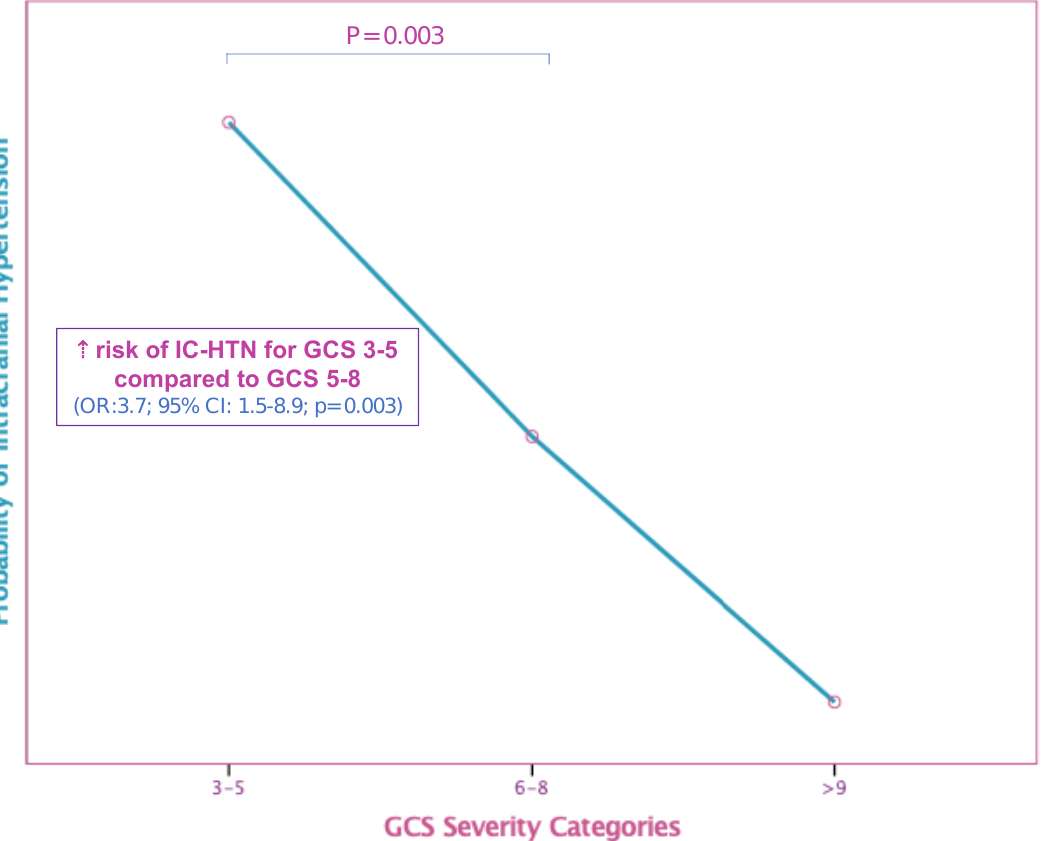
Figure 2. Higher risk of intracranial hypertension (IC-HTN) for severe traumatic brain injury (TBI) cases based on Glasgow Coma Scale (GCS).